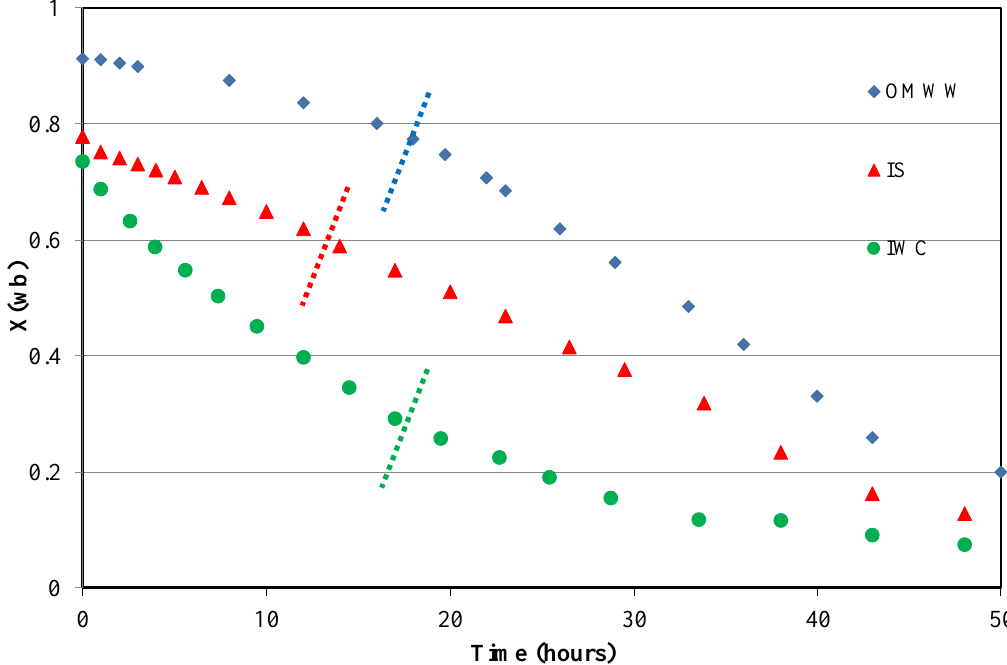
Figure 4. Moisture content profile during the convective drying for raw olive mill wastewater (OMWW), impregnated sawdust (IS), and impregnated wood chips (IWC). One can see that for the three samples, the moisture ratio decreased continuously with the drying time, with different constant rate drying period. This is in accordance with other works dealing with the drying of OMWW [23] and of other biomasses impregnated with OWWW [19,23]. During the first phase of drying, the slope of the moisture curve was very dependent on the sample used. Indeed, the highest one was observed for the IWC, followed by IS, and OMWW. As this stage corresponded to the departure of free or/and weakly bound water, one can attribute the difference to the mixture density and its porosity. Indeed, there were more voids within the impregnated wood chips (IWC), which led to a better air infiltration, whereas the impregnated sawdust (IS) was more compact and formed a paste-like mixture. As for the OMWW, the oily layer transformed into a crust at the top of the liquid, which may explain the slow evaporation rate and why the first stage ended earlier (16 h) compared to IWC (19.5 h) and IS (33.8 h).